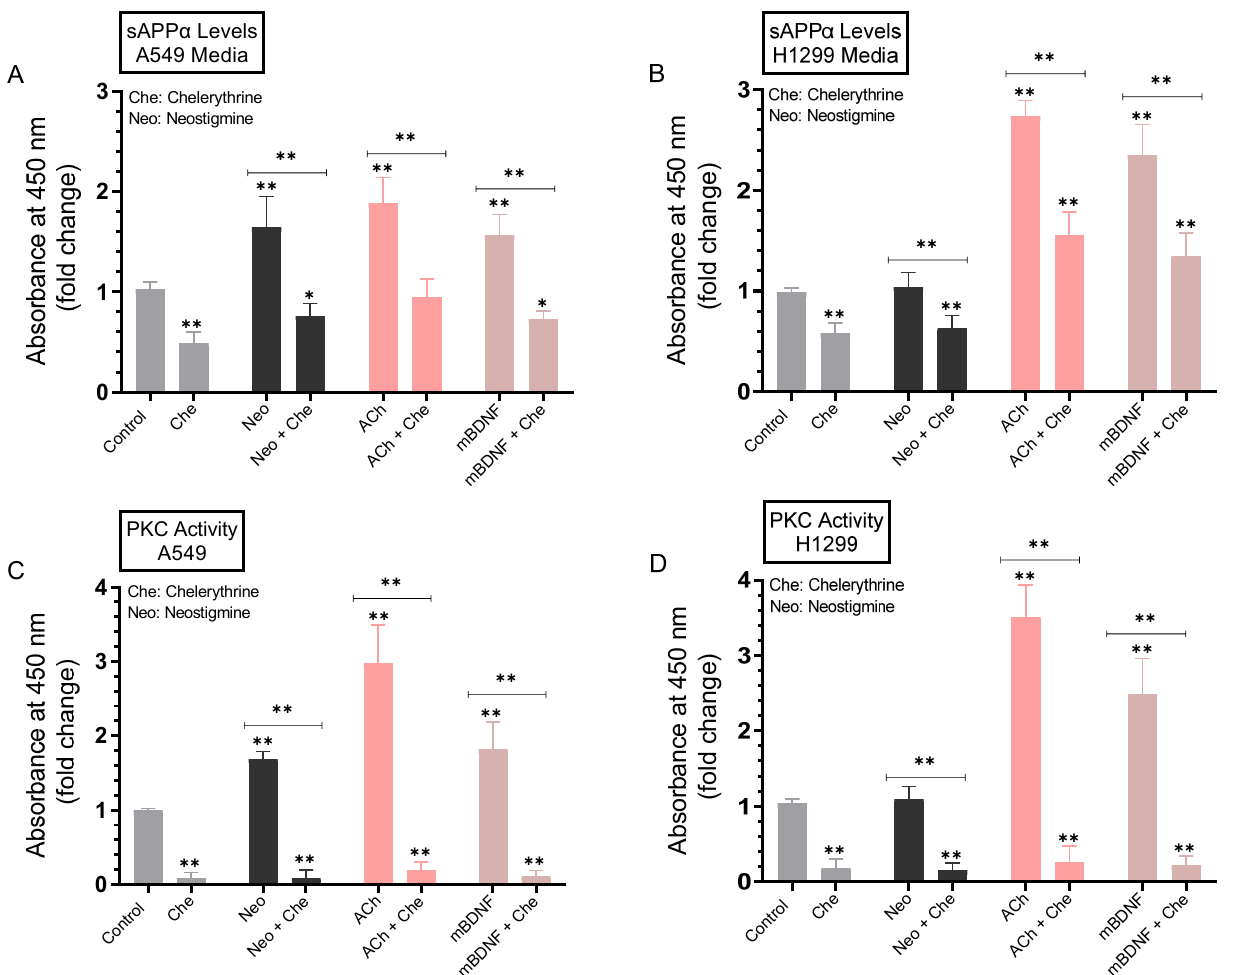
Figure 7. Blocking PKC activity using chelerythrine resulted in decreased sAPP α levels in A549 and H1299 cell media. Cells (0.2 × 10 5 ) were grown in 10% FBS-supplemented media for 24h. The following day, the cell monolayers were incubated in serum-free media for 24h, then treated for 72h with the PKC inhibitor (chelerythrine, 7.5 μ M), neostigmine (Neo, 50 μ M), ACh (100 nM), mBDNF (5 nM), or in combination. Levels of sAPP α released into the culture media of A549 (A) and H1299 (B) cells during the 3-day incubation period were measured as described in the Methods section on the same amount of protein (3 μ L of 600 μ g/mL total protein) of each sample. PKC activity was measured in A549 (C) and H1299 (D) cells as described in the Methods section. Data from five independent assays, each carried out in triplicate, were averaged, normalized, and expressed as fold change relative to untreated cells (control) using the GraphPad 9.4.1 software. The graphs summarize the results expressed as means ± SD (n = 5). Asterisks (*) indicate a statistically significant difference from the corresponding control of each cell line while absence of asterisks indicates no significance. Mann-Whitney test, *p<0.05, **p<0.0l.